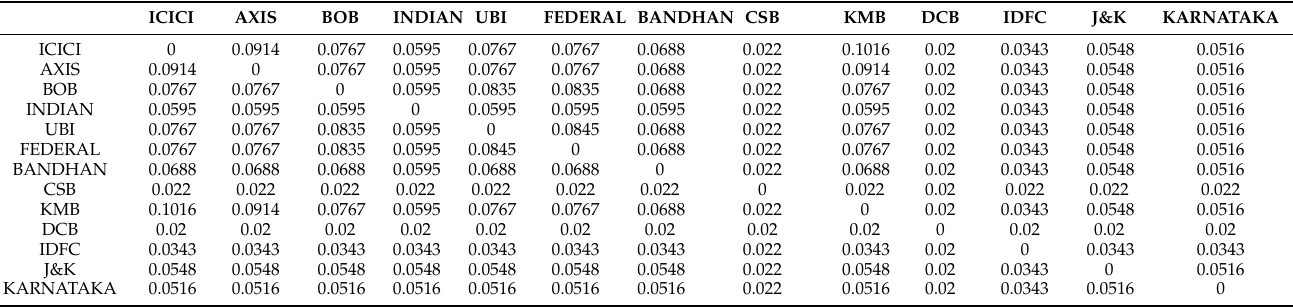
Table 8. Adjacency matrix of the strength of connectedness (1st component): reduced list of 13